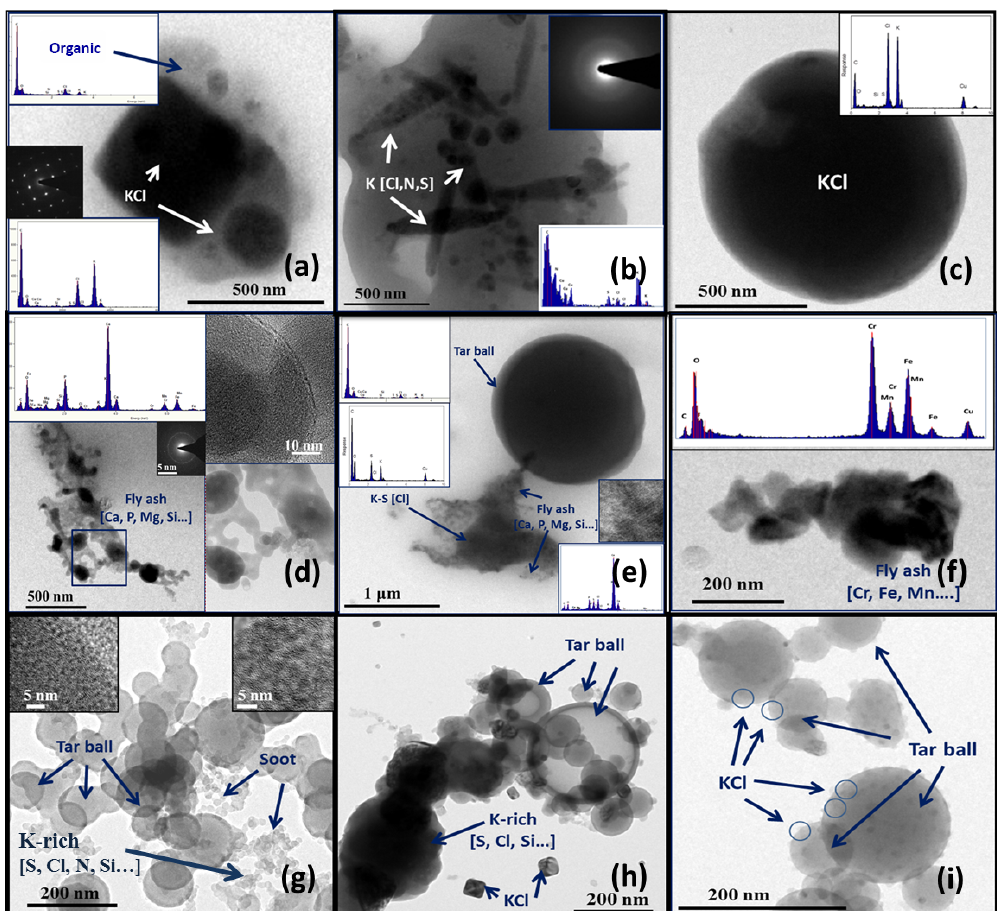
Figure 4. Transmission electron microscope (TEM) images and EDX analysis of fresh agricultural residue burning particles. (a) – (c) Crystal and amorphous KCl particles internally mixed with sulfate, nitrate, and carbonaceous materials. (d) – (f) Heavy-metal-bearing fractal-like fly ash particles. (e) – (g) Chain-like soot particles and tar